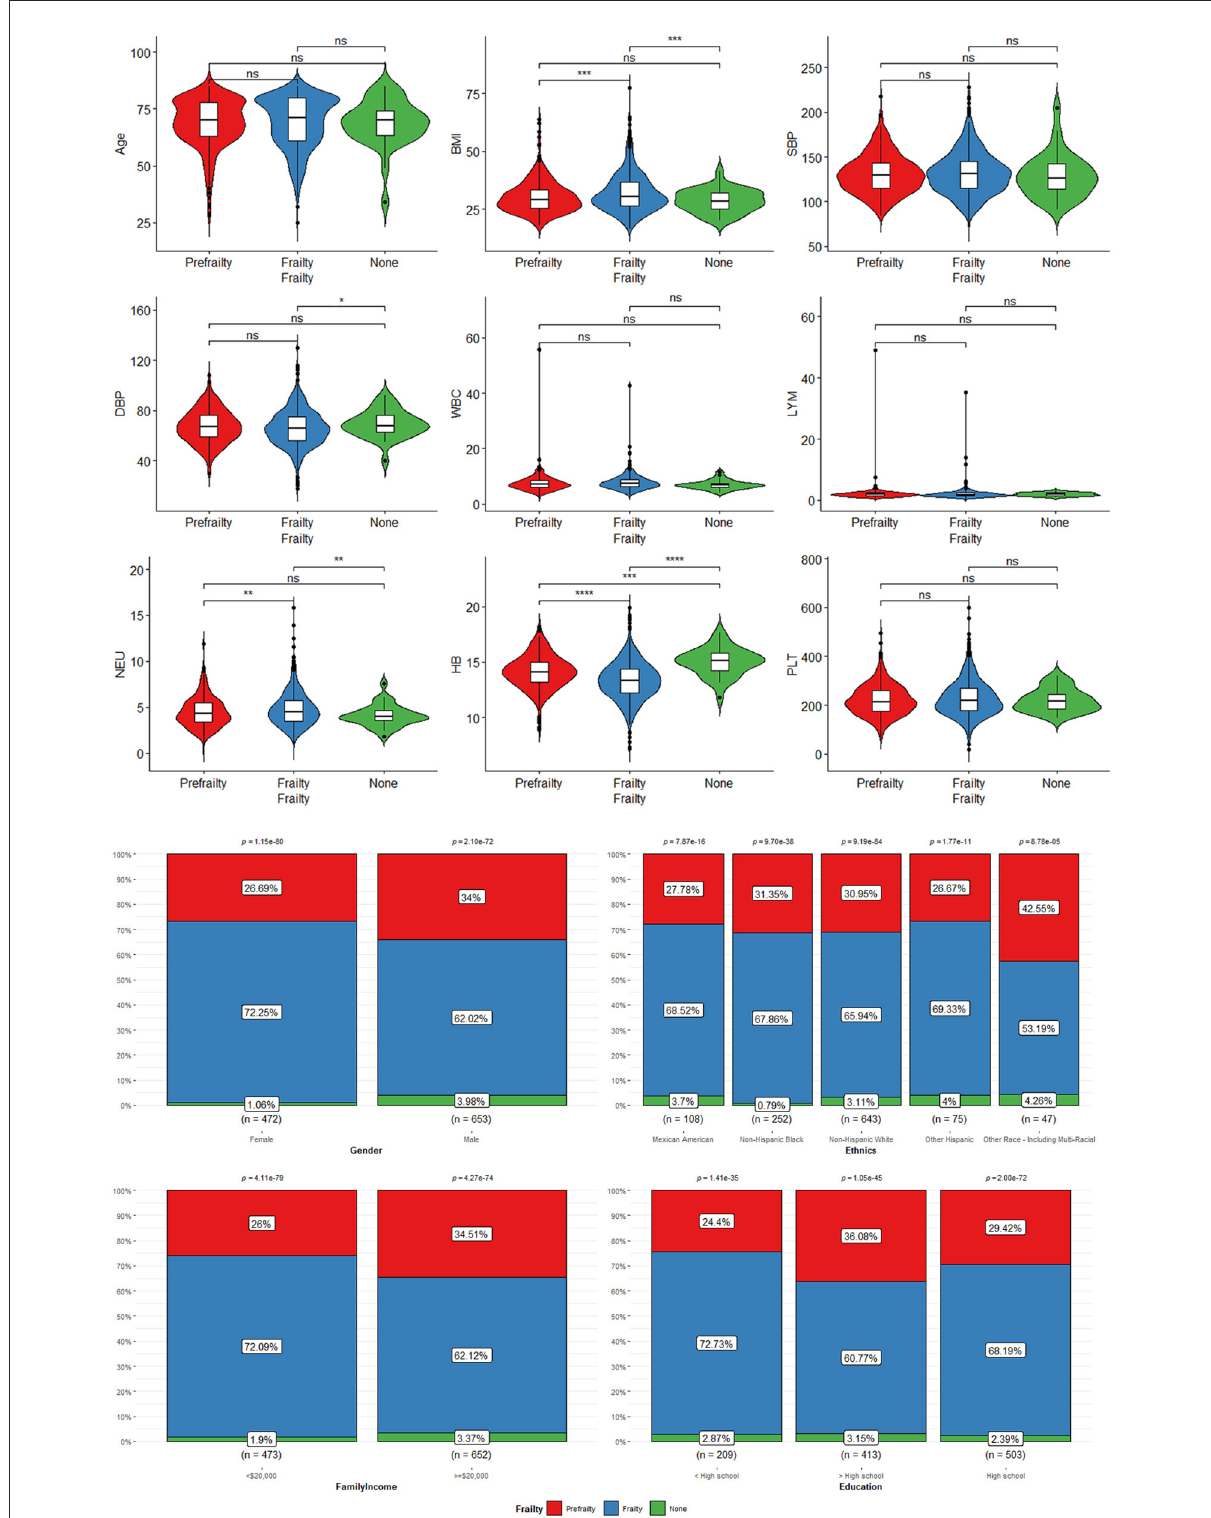
FIGURE6 The characteristics of CHF participants with frailty, pre-frailty, and non-frailty: *means P < 0.05; **means P < 0.01; ***means P < 0.001; ****means P < 0.0001. “ns” means no statistical